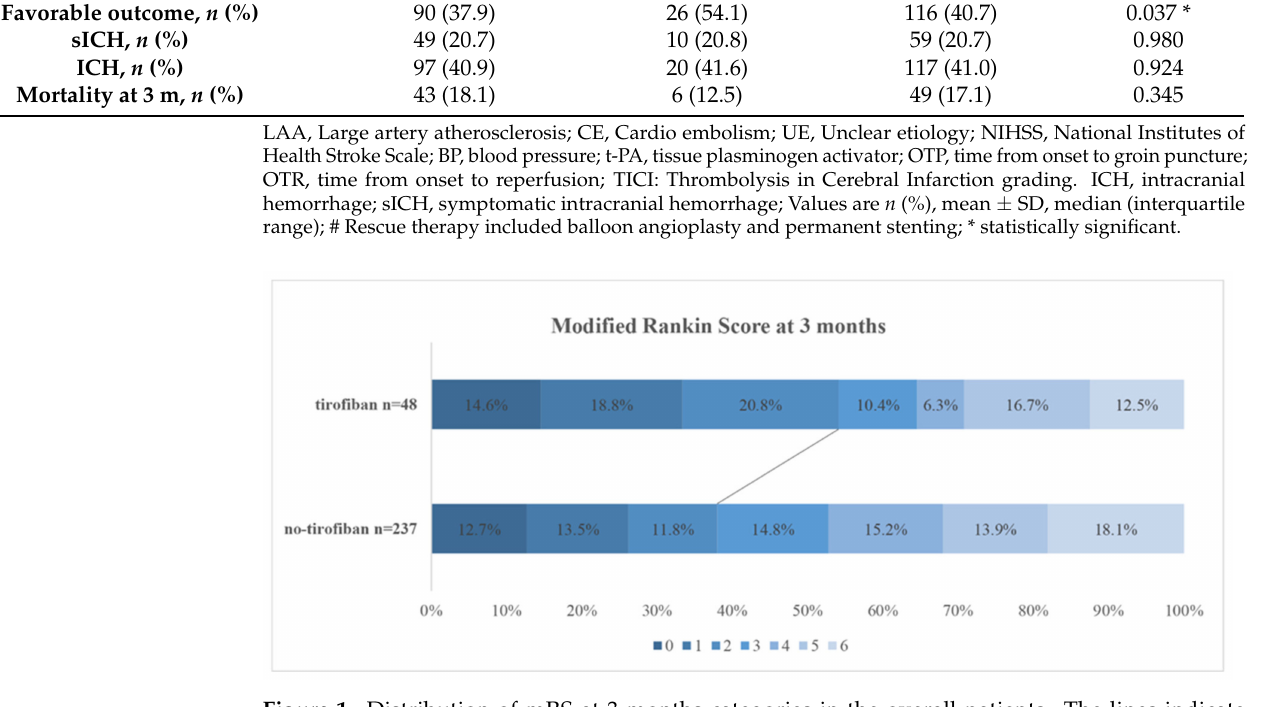
Figure 1. Distribution of mRS at 3 months categories in the overall patients. The lines indicate differences in favorable outcome (mRS 0–2) between groups. mRS, modified Rankin